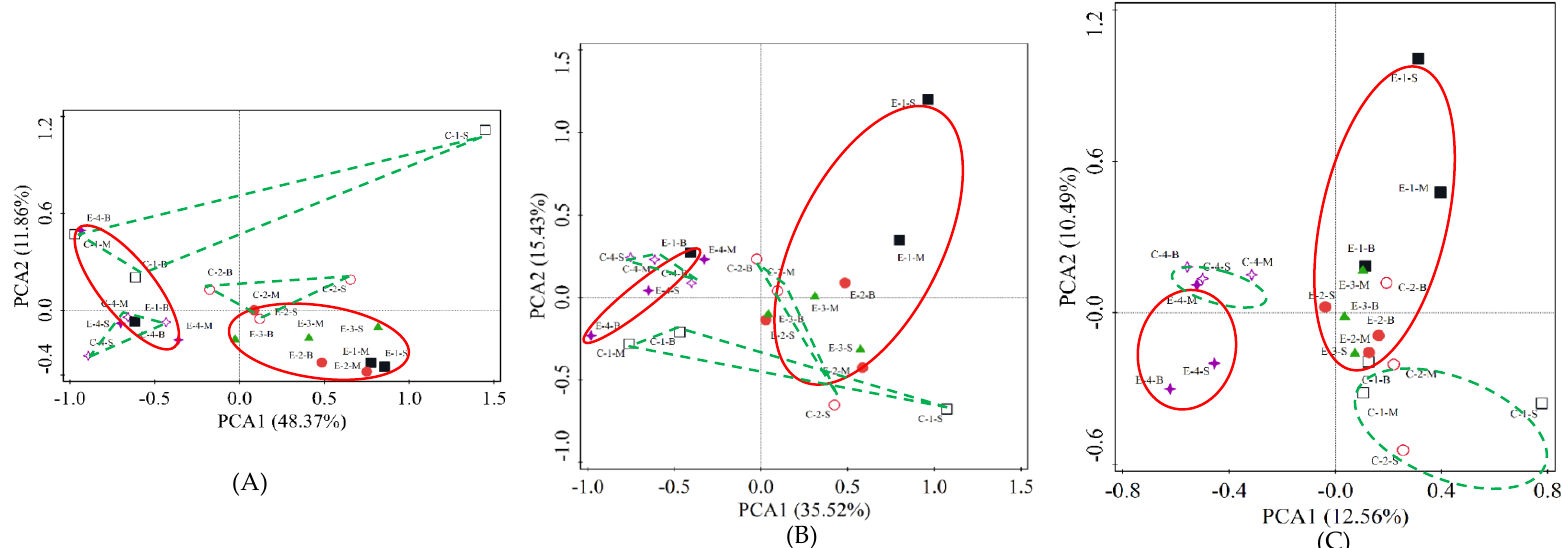
Figure 8. Principal component analysis (PCA) of water samples in the enhanced and control areas: ( A ) at phylum level; ( B ) at class level; ( C ) at genus level.